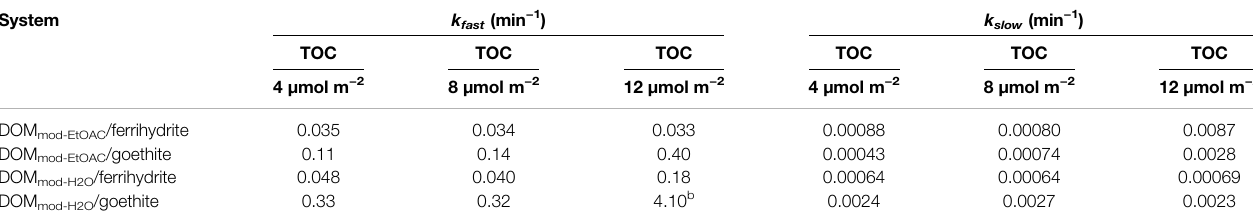
TABLE 1 | Rate constants obtained from fi tting Eq. 2 to the [Fe 2+ ] in Figure 2 . a